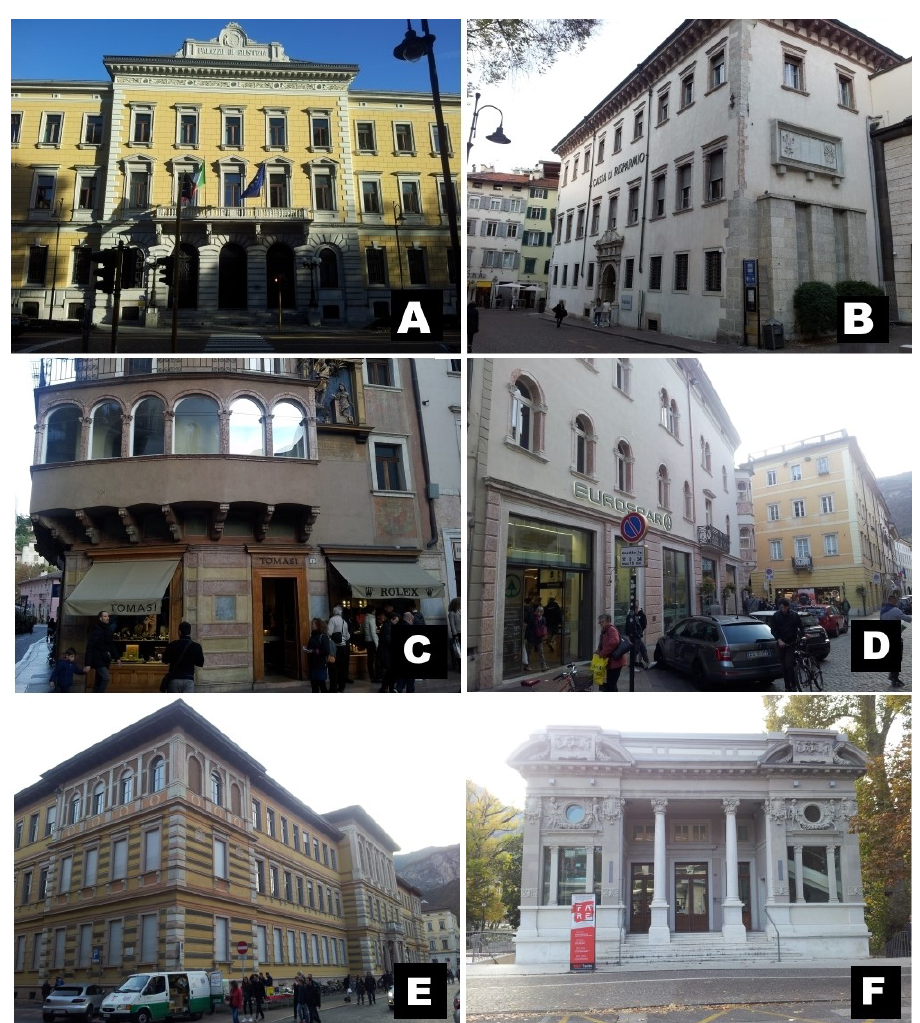
Historic buildings in the centre of Trento: ( A ) the court, ( B ) a bank, ( C ) a jewellery shop, ( D )